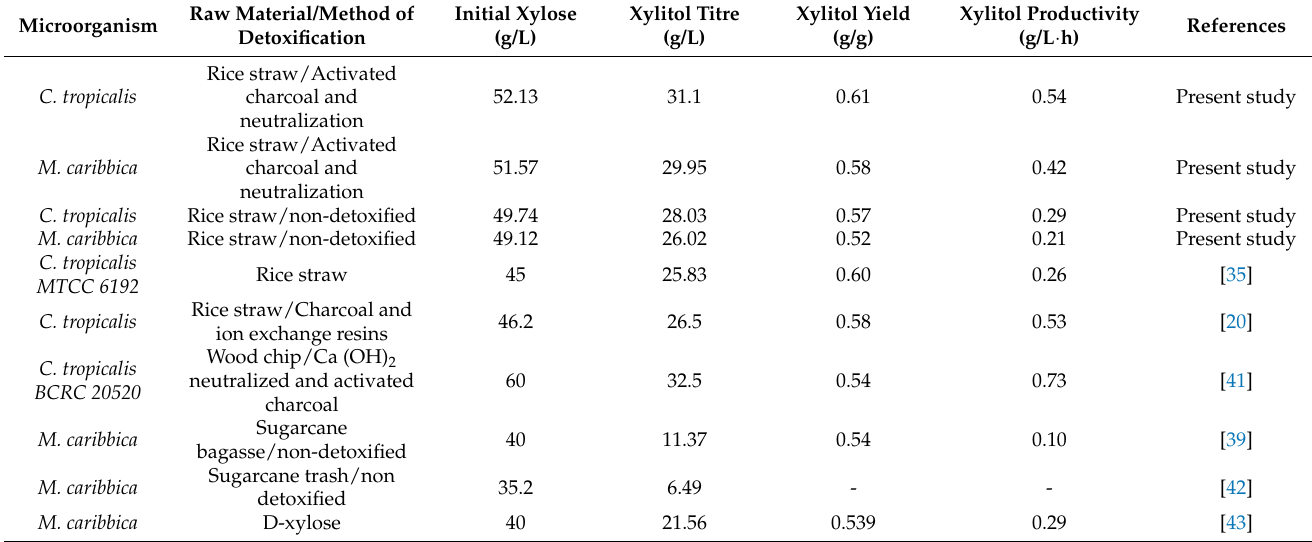
Table 3. Comparison of xylitol production by different